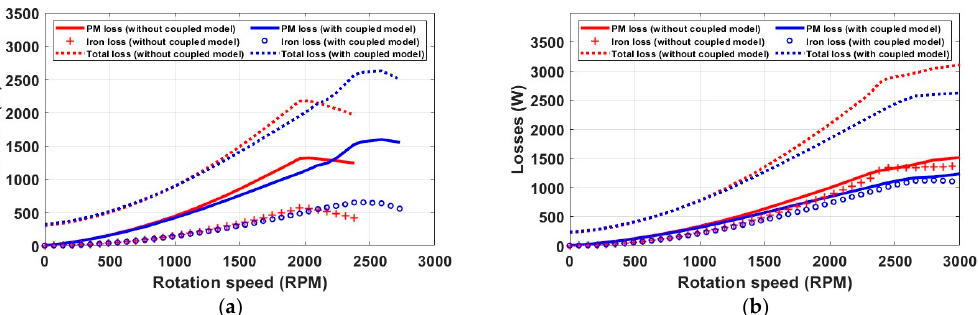
Figure 10. Torque speed curves of ( a ) the modular machine and ( b ) the non-modular machine with or without considering the EM–thermal coupling.